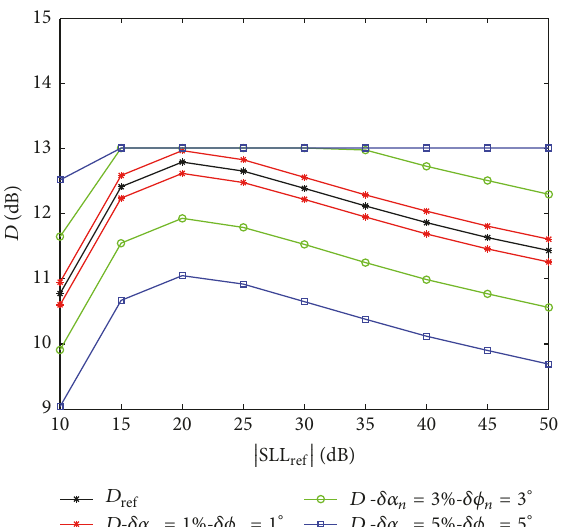
Figure 6: Directivity interval based on IA against ISLL ref .